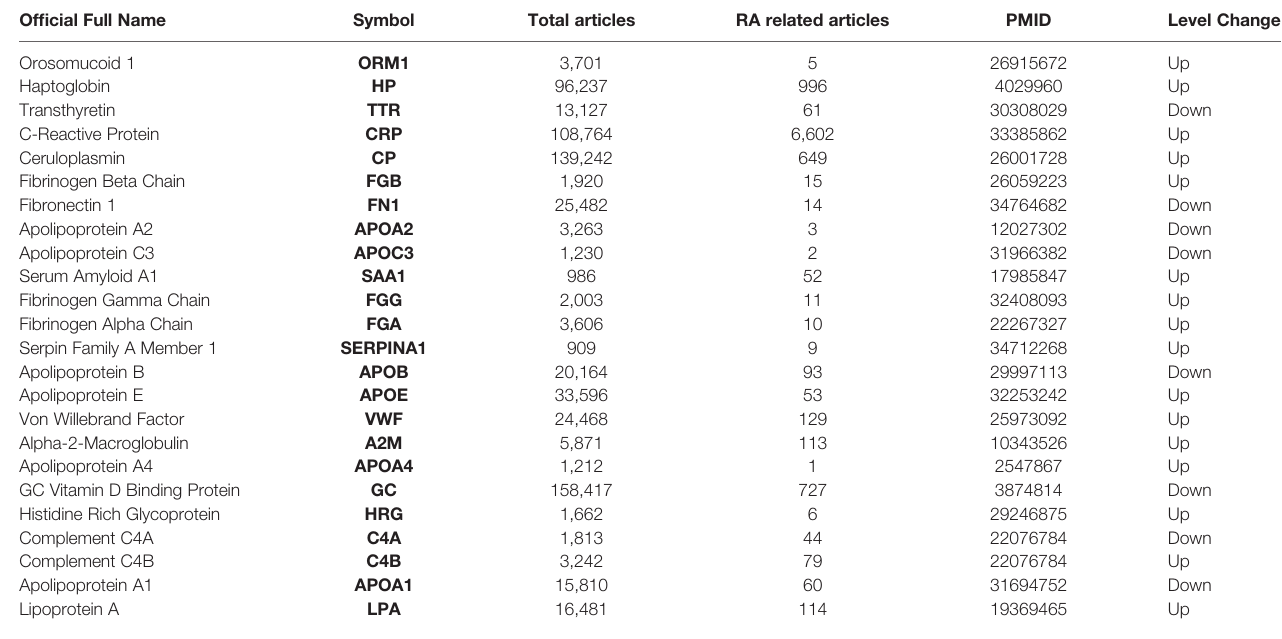
TABLE 1 | Literature summary of differential proteins. Of fi cial Full Name